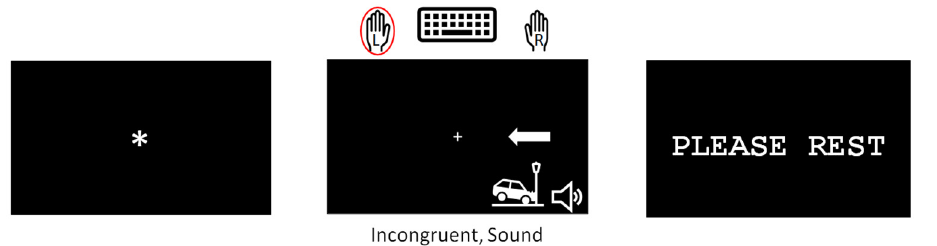
Figure 1. Example of one trial of the modified Simon task.